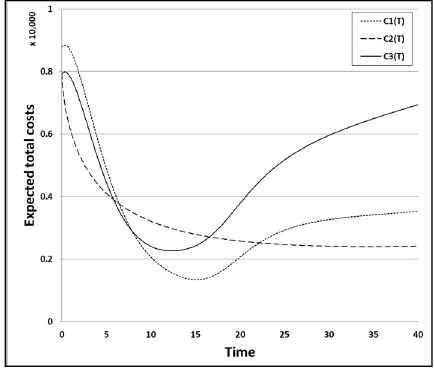
Figure 11. Expected total cost for the baseline case.